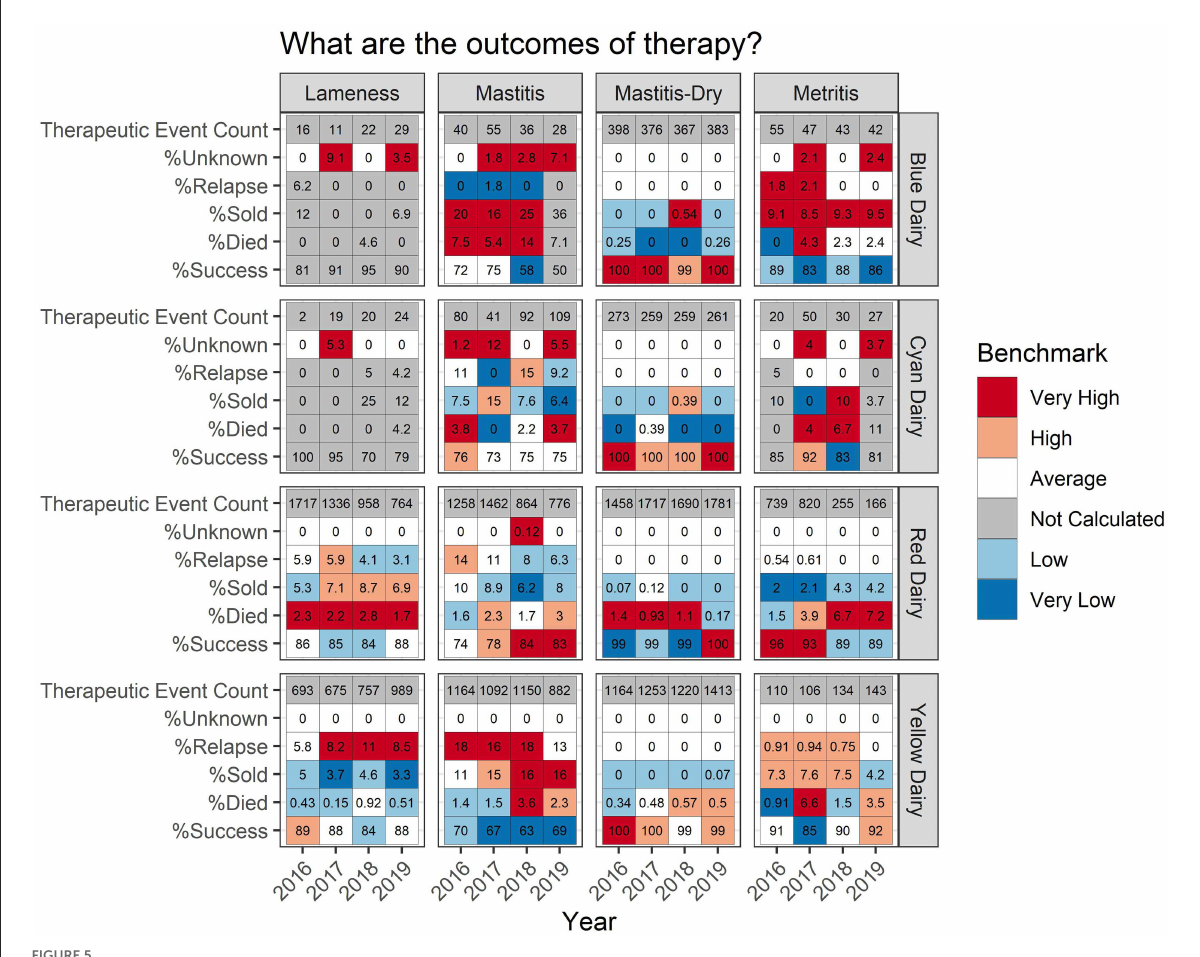
Red Dairy and Cyan Dairy had RT-ratios ranging from